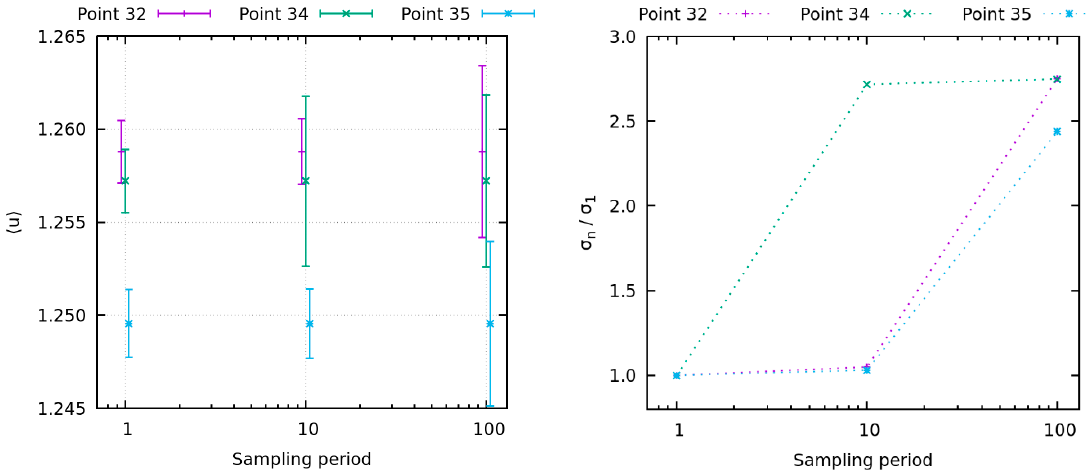
Figure 15. Comparison of results with different sampling periods. On the left, the average streamwise velocity component in three points together with the 2𝜎 uncertainty is shown. On the right, the uncertainty change with sampling rate for the same three points is shown.